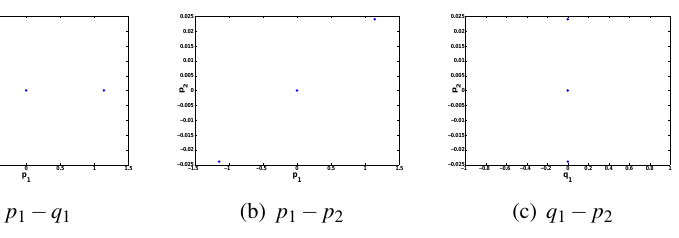
Fig. 3 Section of global random point attractors for ϕ NGM 3 with case II